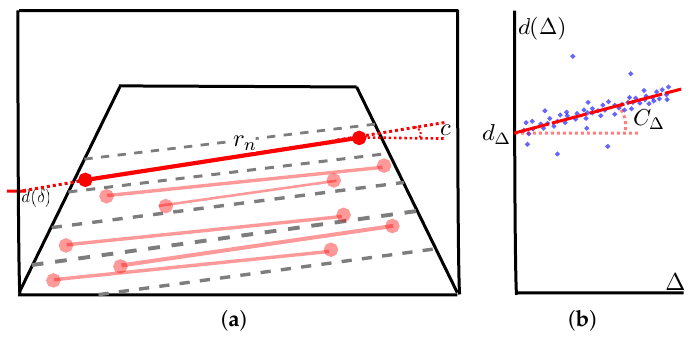
Figure 6. Assessment of the impact that the roll angle ( ρ ) has on the v-disparity and on the road profile. ( a ) Visible image of a highway traffic scenario; ( b ) v-disparity; ( c ) v-disparity after adding a 9 ◦ roll angle; ( d ) v-disparity after adding an 18 ◦ roll angle.